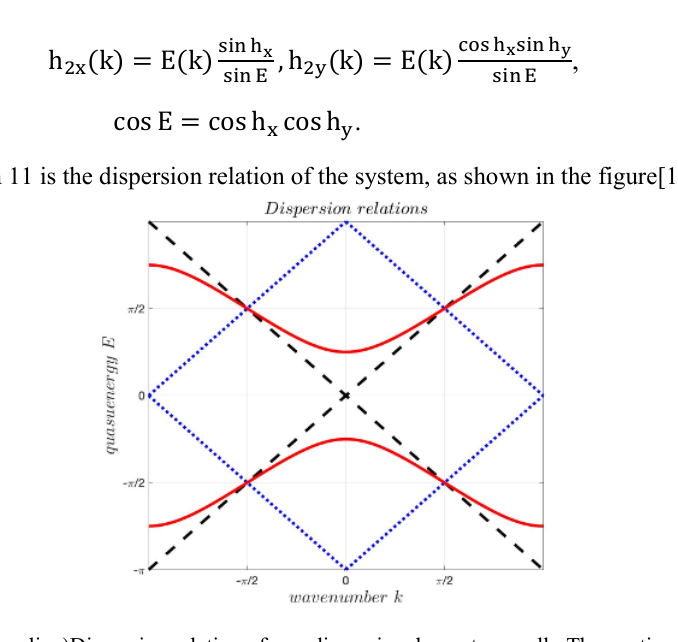
. The two gapless dispersion relations are and is E = 0 ± π